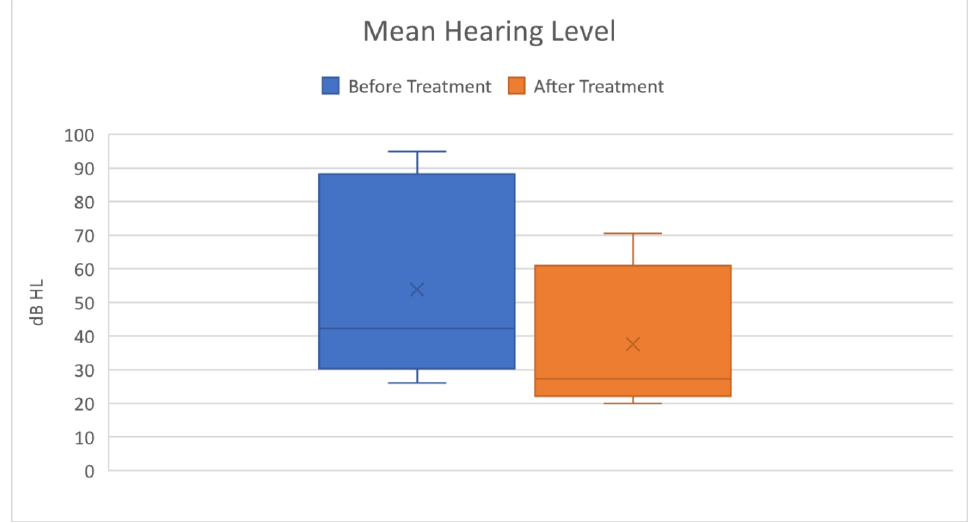
Figure 7. The overall Mean Hearing Level had a significative improvement after treatment ( p = 0.0016).